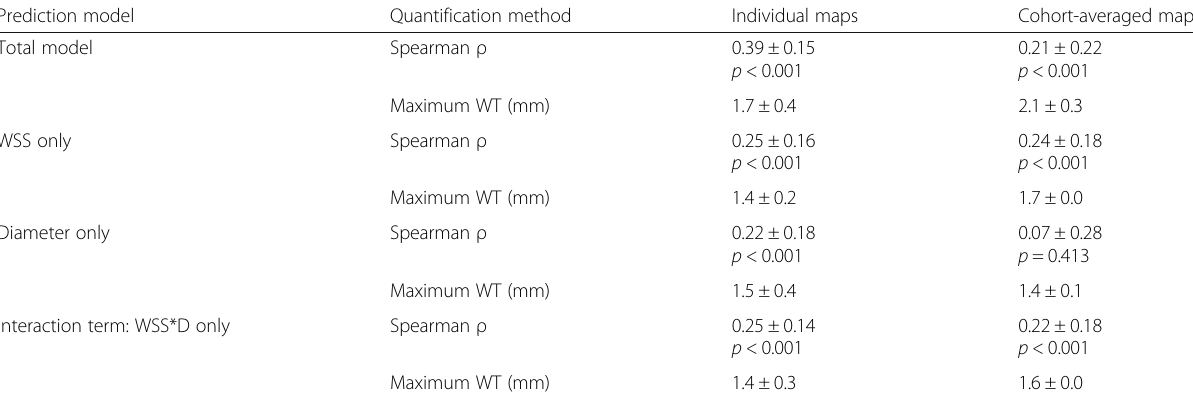
Table 1 Spearman ’ s ρ and maximum WT for the agreement between the predicted WT maps and the original WT maps based the individual maps on the cohort-averaged